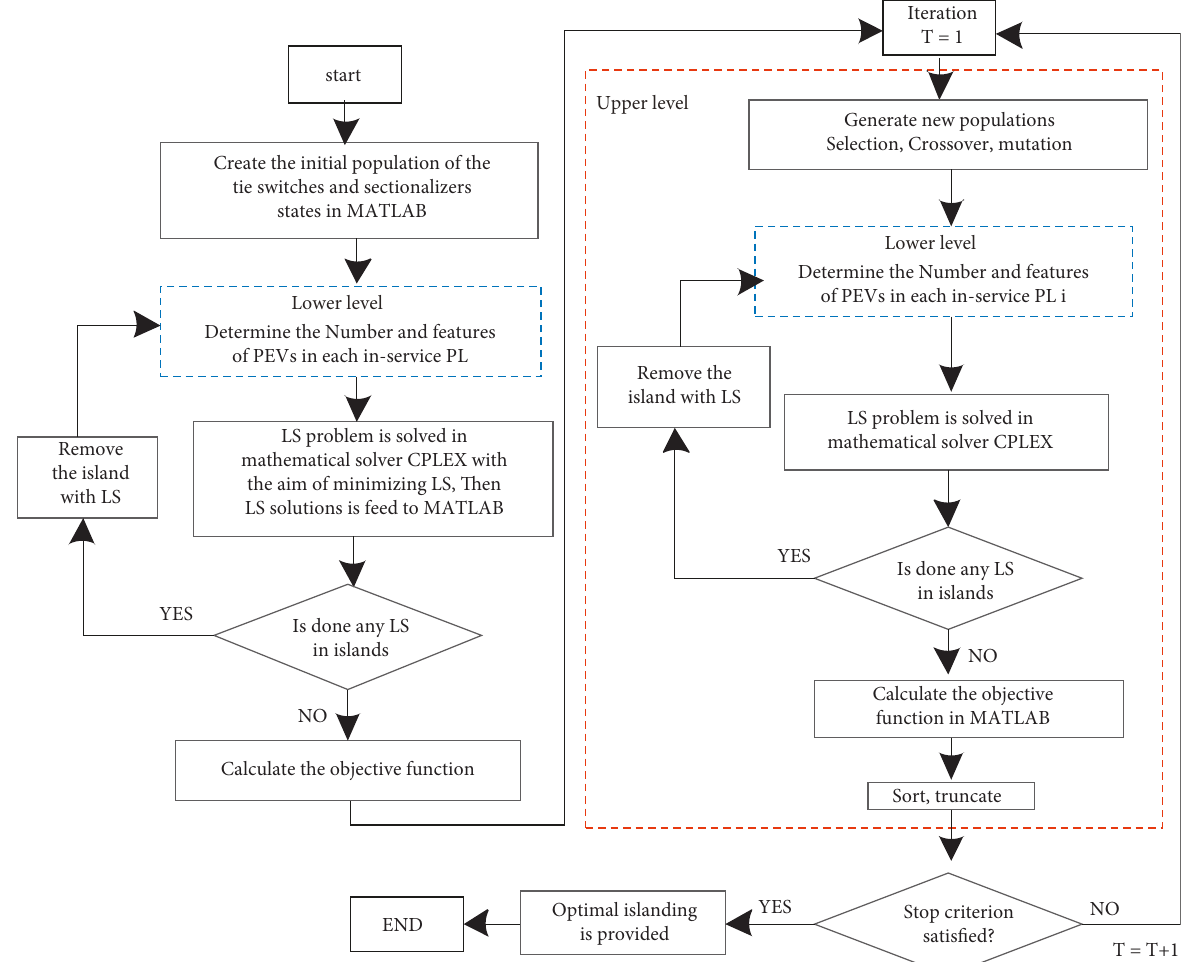
Figure 5: Bilevel optimization flowchart without the possibility of load